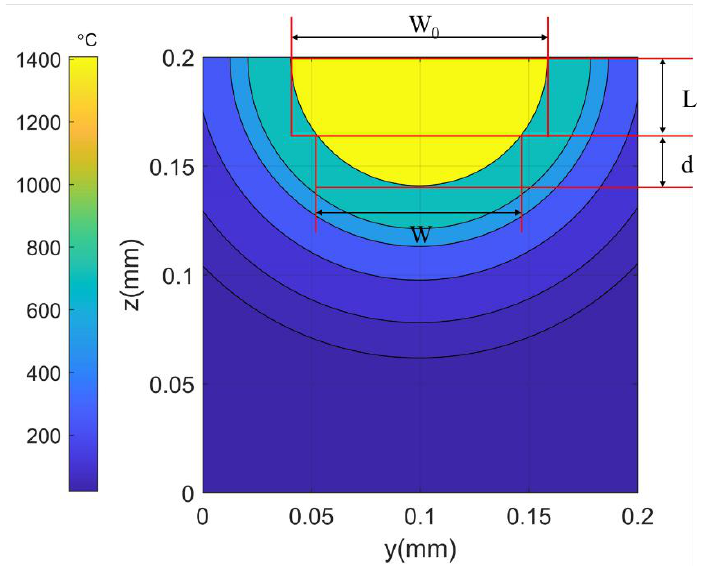
Figure 3. Temperature distribution in y-z plane. Laser power is 500 W. Scan speed is 400 mm/s. Hatch space is 80 µm. Layer thickness is 35 µm. The yellow portion represents the molten pool transverse cross-section. 𝑊 0 represents the width of powder consumed band. 𝑊 represents the molten pool width after solidification. 𝐿 represents the layer thickness. 𝑑 denotes the remelted depth.